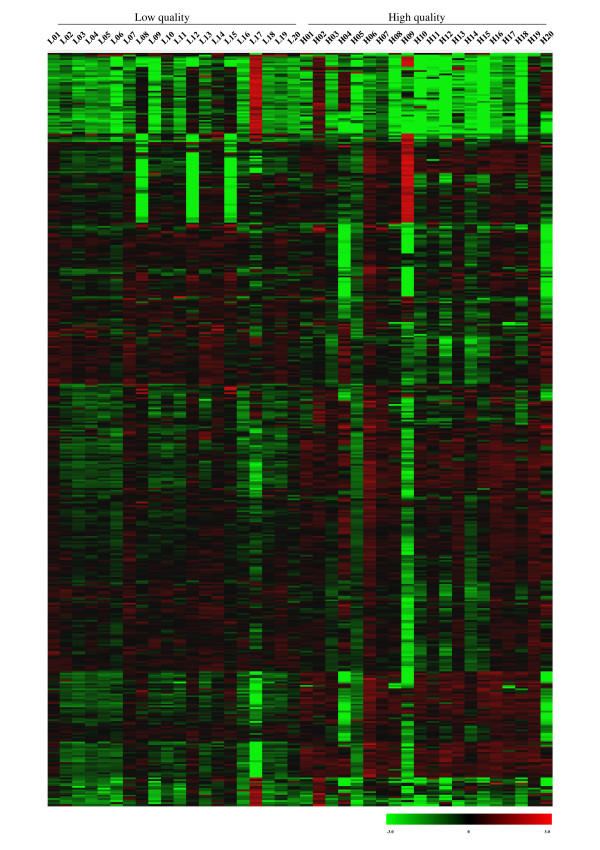
The expression profiling of 439 ESTs in 2 × 20 recombinant inbred lines contrasting for dNDF. The color saturation reflects the magnitude of the log2 expression ratio (Cy5/Cy3) for each transcript. Each row represents an EST. Red and green colors mark up-regulated and down-regulated ESTs in individual line, respectively. The color log2 scale is provided at the bottom of this figure.